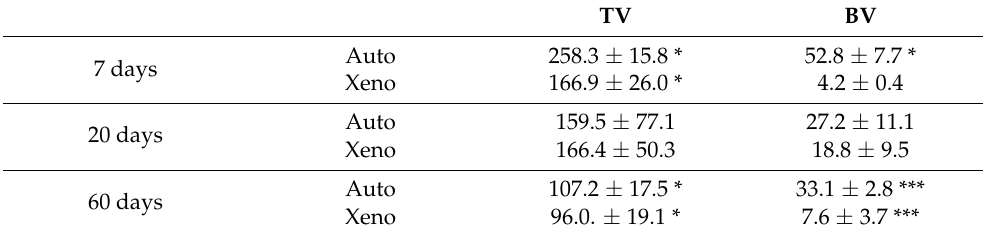
Table 1. Micro-computed tomographic evaluation of the total volume and bone volume in the various periods of healing. TV: total graft volume; BV: bone volume = new bone + residual graft.